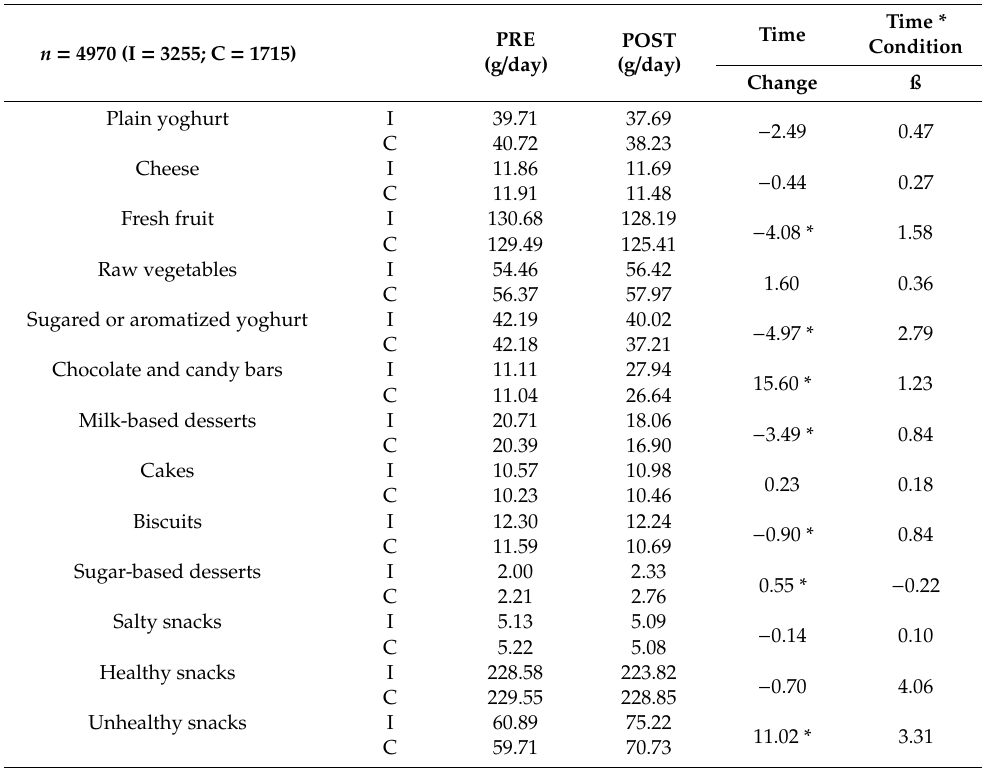
Table 3. Time and interaction e ff ects for the di ff erent food categories in the total sample (adjusted for age and